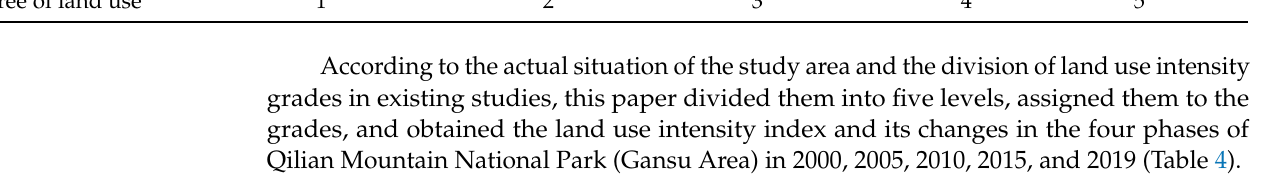
Table 4. Land use intensity and rate of change in Qilian Mountain National Park (Gansu